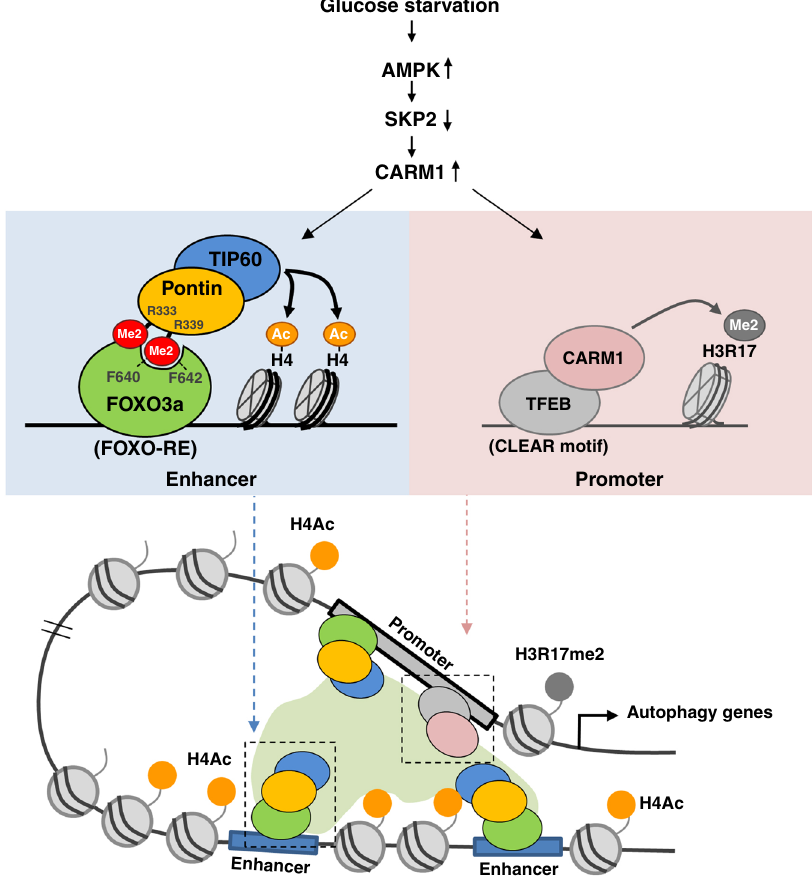
Fig. 9 Schematic representation of CARM1 – Pontin – FOXO3a signaling axis and CARM1 – TFEB signaling axis for transcriptional activation. Schematics for the transcriptional activation of FOXO3a-dependent autophagy and lysosomal genes upon glucose starvation. Activated CARM1 methylates Pontin, and then methylated Pontin binds FOXO3a through a methyl-binding domain of FOXO3a with Tip60 and increased H4 acetylation. CARM1 – Pontin – FOXO3a signaling axis works for FOXO3a response elements with increased H4 acetylation, whereas TFEB – CARM1 signaling axis works for CLEAR motifs with increased H3R17me2 level irrespective of Pontin methylation